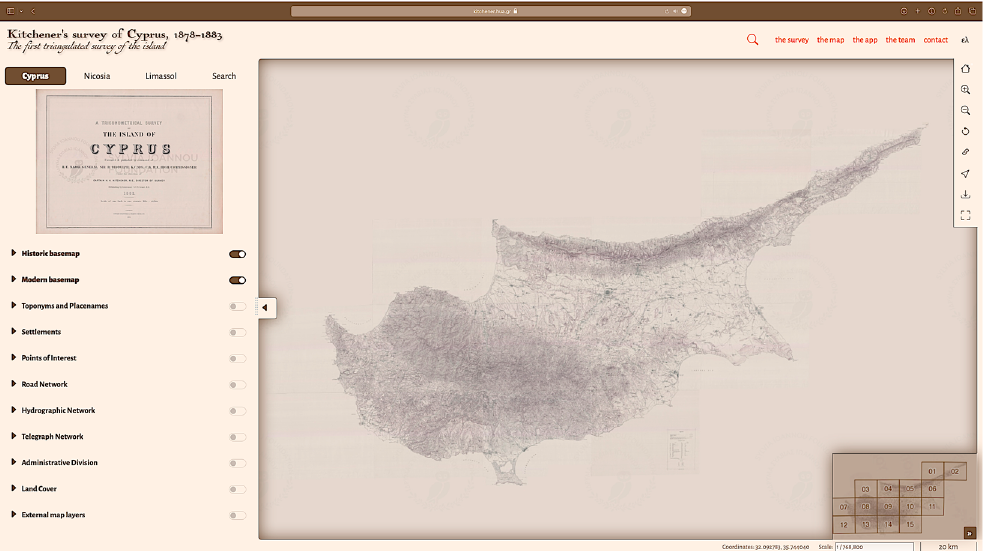
Figure 5. The main screen of the Web application (https://kitchener.hua.gr/en, accessed on 10 Janu- ary